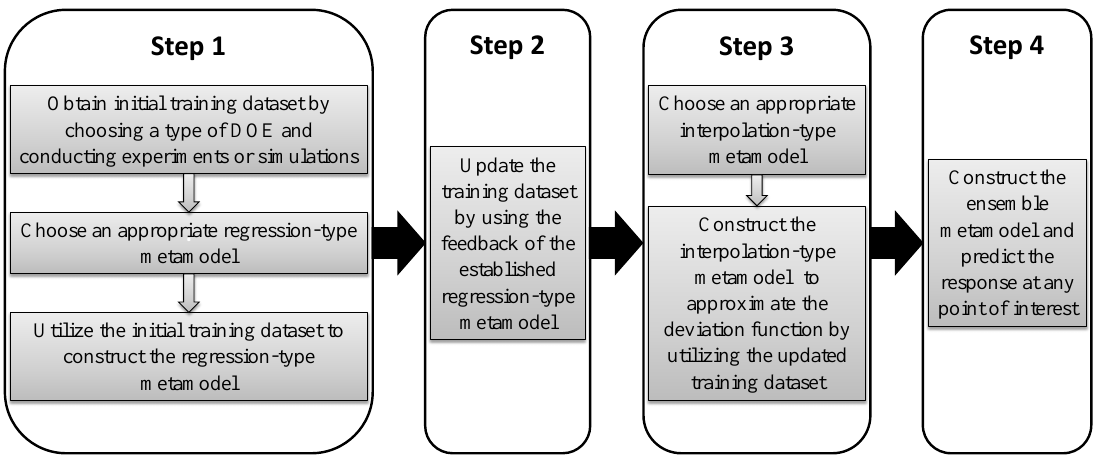
Figure 1. Flowchart of the proposed approach for building ensembles of regression-type and interpolation-type